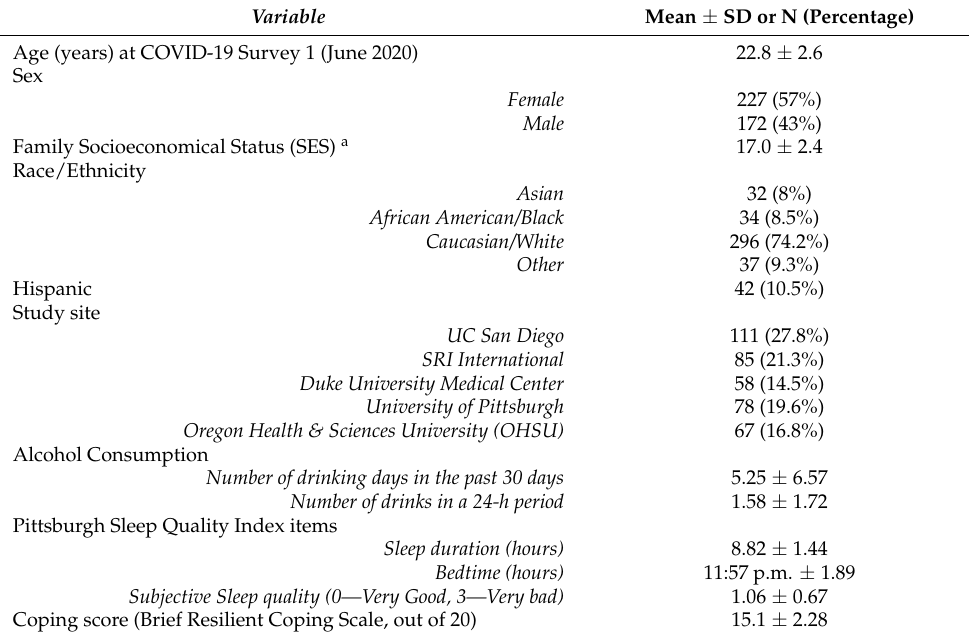
Table 1. Demographics of the 399 participants from the NCANDA cohort included in the analysis. Variables were measured at COVID-19 Survey 1 (June